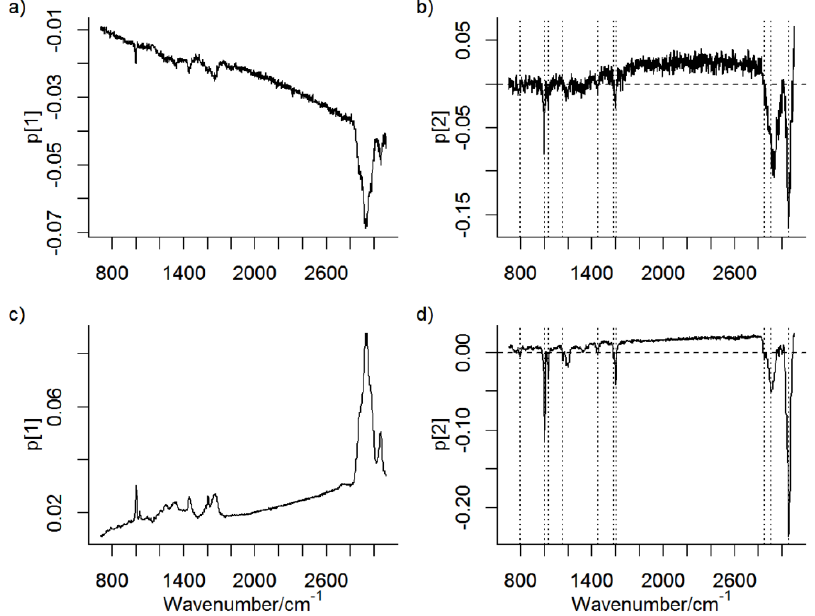
Figure 1. Loadings for principal components (PCs) (( a ) PC1 and ( b ) PC2) for principal component analysis (PCA) of the 500 nm image. Loadings for ( c ) PC1 and ( d ) PC2 for PCA of the 100 nm image. Raman bands assigned to polystyrene submicron (PS) particles are marked with dashed lines.